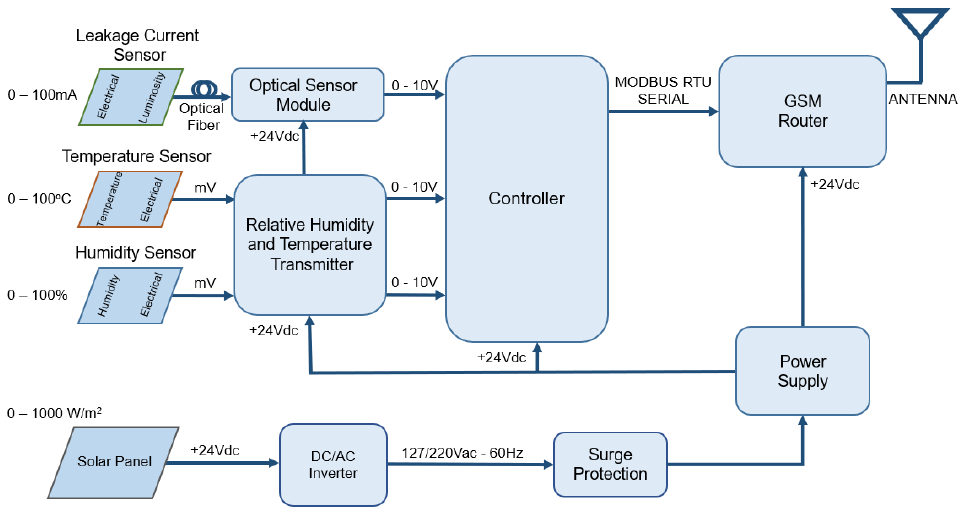
Figure 2. Block diagram of the Remote Unit.